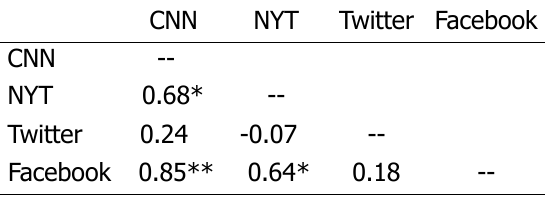
Table 2. Bivariate Spearman's rho correlation mat- rix for issue salience by topical category in cover- age on CNN, New York Times, Twitter and